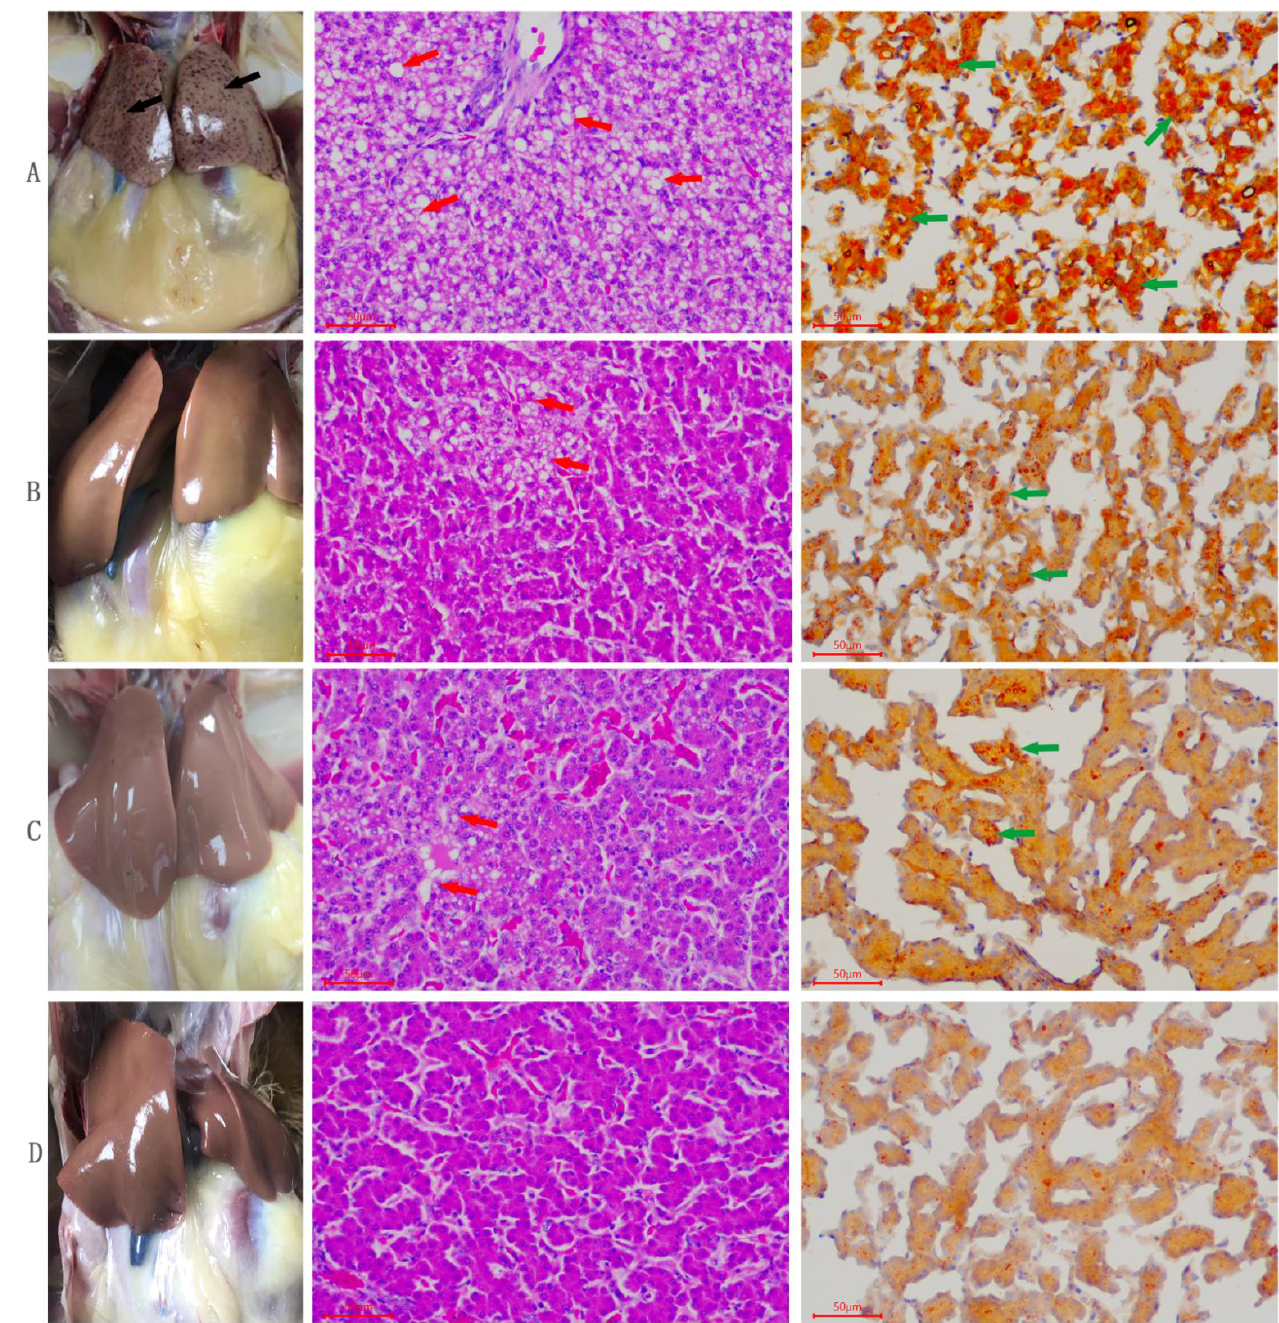
Figure 1. Effects of quercetin, vitamin E, and their combination (Q + VE) on liver morphological and histological changes of aging breeder hens. This figure shows the Hematoxylin-eosin (HE) staining and oil red results of the hen’s liver tissue. ( A ) (Control Group): severe hepatic steatosis. ( B ) (Quercetin Group): mild hepatic steatosis. ( C ) (Vitamin E Group): moderate hepatic steatosis. ( D ) (Q + VE Group): normal liver morphology without any steatosis. The red arrow indicates the “fatty vacuoles”, the green arrow indicates the “lipid droplets” .